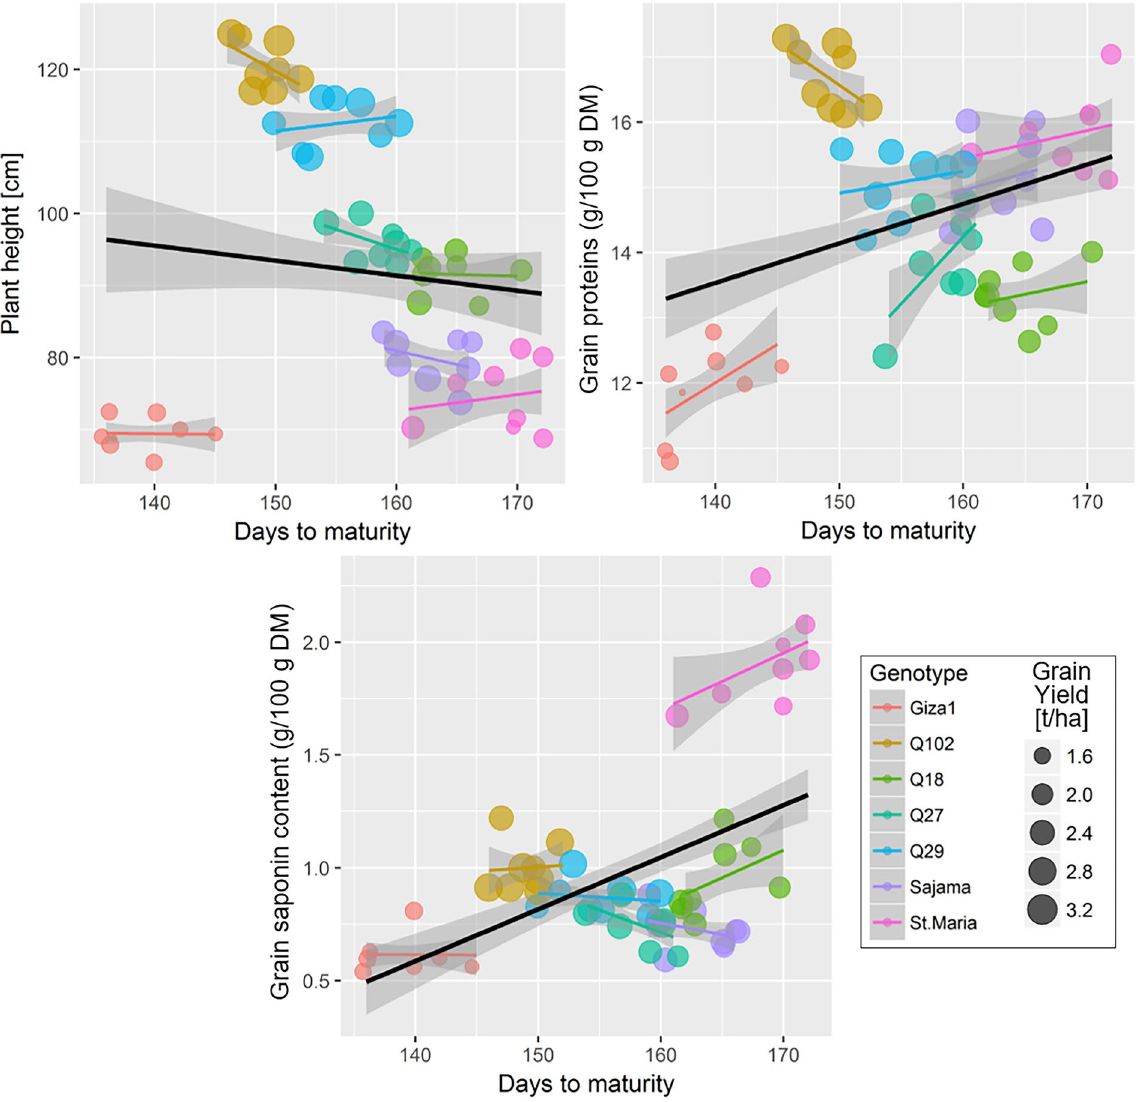
Figure 8. Relationship between maturity duration, plant height, and grain nutritional quality for different quinoa ( Chenopodium quinoa ) genotypes grown in open field under hot-arid conditions. The color of points is mapped to genotypes, and size values are set to grain yield. The solid lines (black for all genotypes combined, colors for studied genotypes) represent a linear regression with a GLM fit, with 95% confidence regions in light